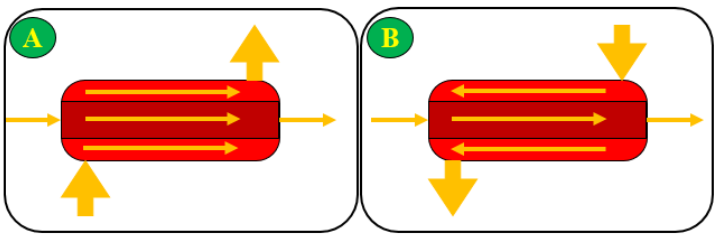
Figure 1. Parallel flow HE (A), Counter flow HE (B)